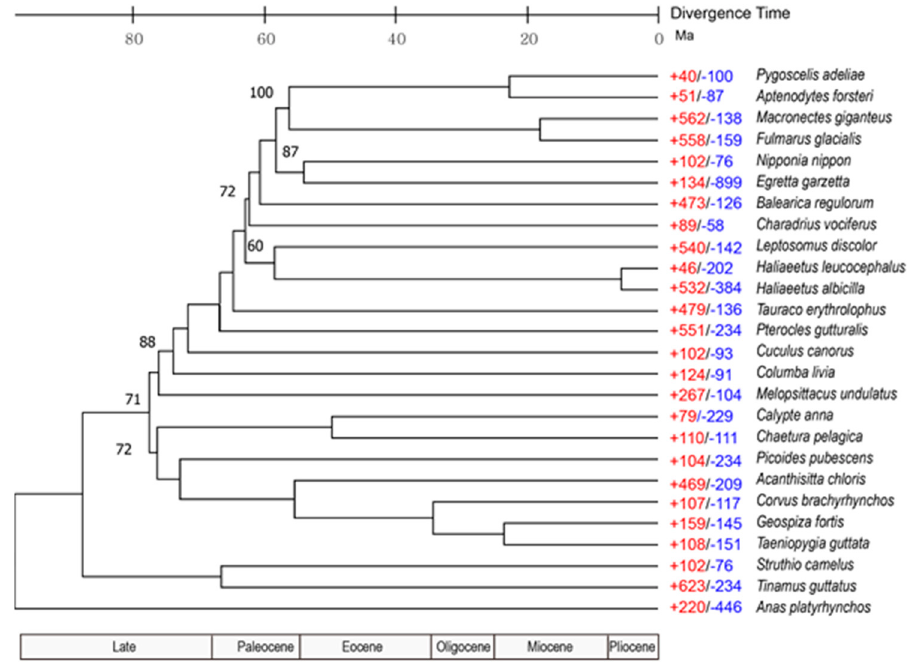
Figure 4. Phylogenetic tree and gene family gain-and-loss analysis, including the number of gained (+) and lost ( − ) gene families. All bootstrap values are 100%, except where denoted. (+) and lost ( − ) gene families. All bootstrap values are 100%, except where